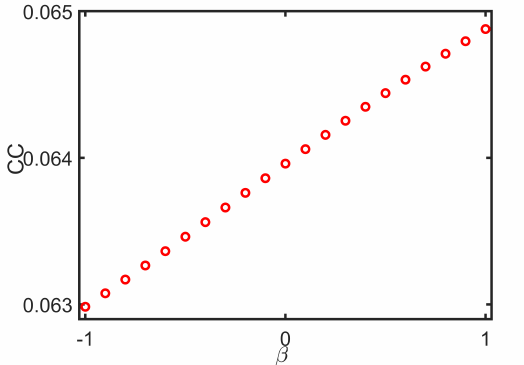
Figure 5. Average clustering coefficient for increasing value of β within the relay